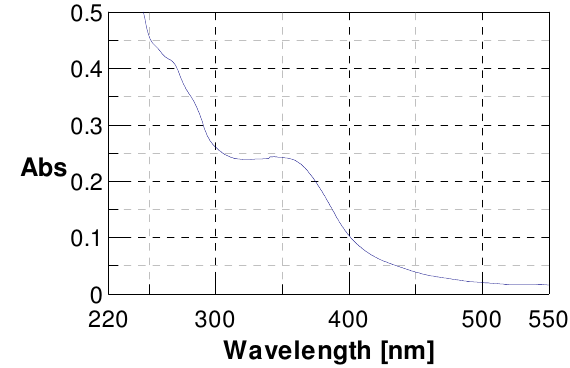
Fig. 2. UV-VIS spectrum for phenolic compounds in